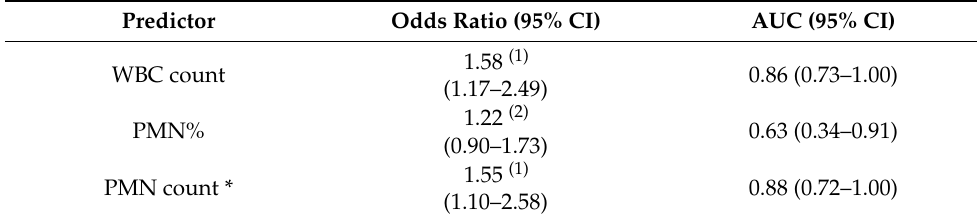
Table 2. Odds ratio and area under the curve (AUC) with 95%CI quantifying the effect of each predictor on the probability of (septic arthritis) SA (univariable models). CRP, WBC count, PMN (%) and PMN count are from synovial